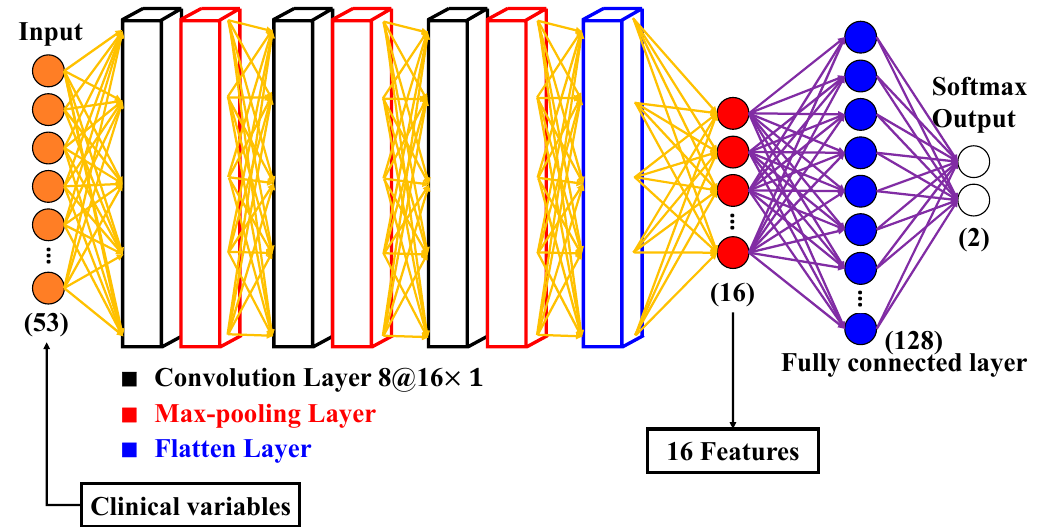
Figure 2. Structure of Convolutional Neural Network (CNN) in this experiment.